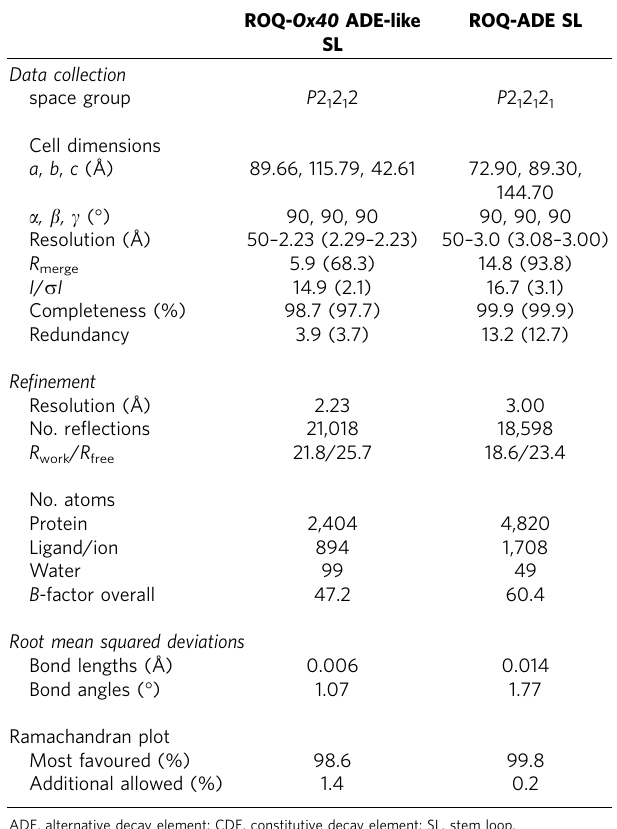
Table 1 | Data collection and refinement statistics. ROQ- Ox40 ADE-like